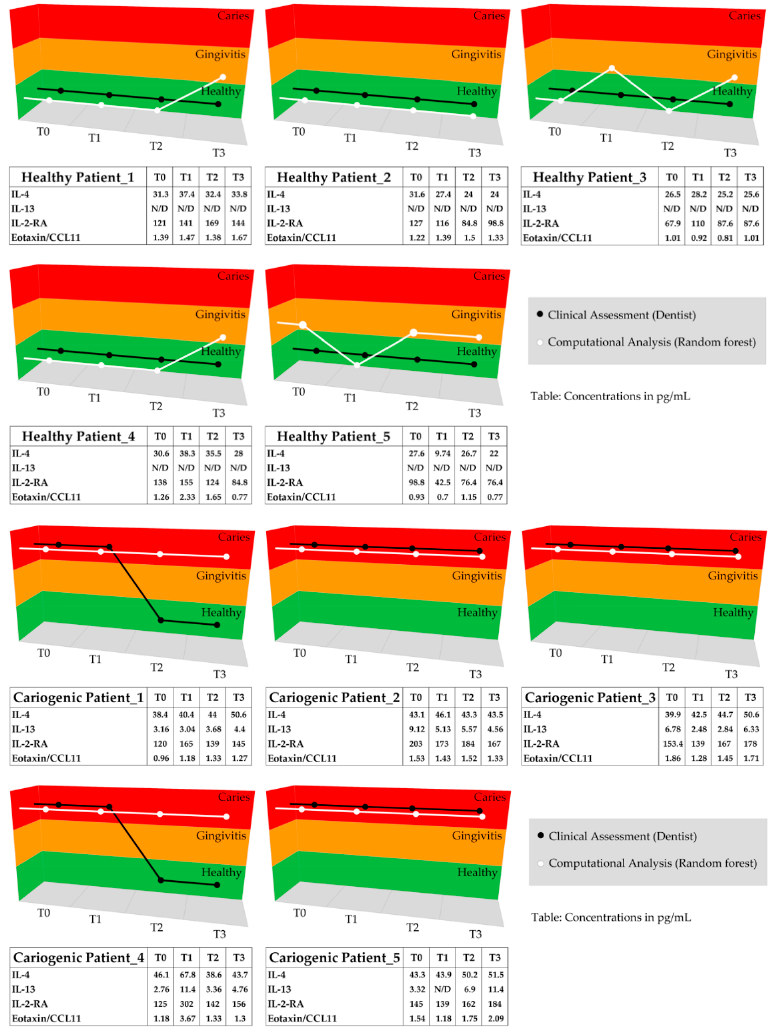
Figure 7. The clinical statuses of five healthy and five caries patients were assessed and classified by dental specialists as well as by biomarker-based RF predictions (Healthy Patient_1 to _5, and Cariogenic Patient_1 to _5). The graphs visualize and compare the classification results based on the RF modeling (white) and the clinical assessment by dental specialists (black) for each timepoint (T0 = baseline, T1 = after 4 months, T2 = after 5 months, and T3 = after 6 months). The tables below the graph show the respective biomarker concentrations in pg/mL, with N/D = values below the detection limit.